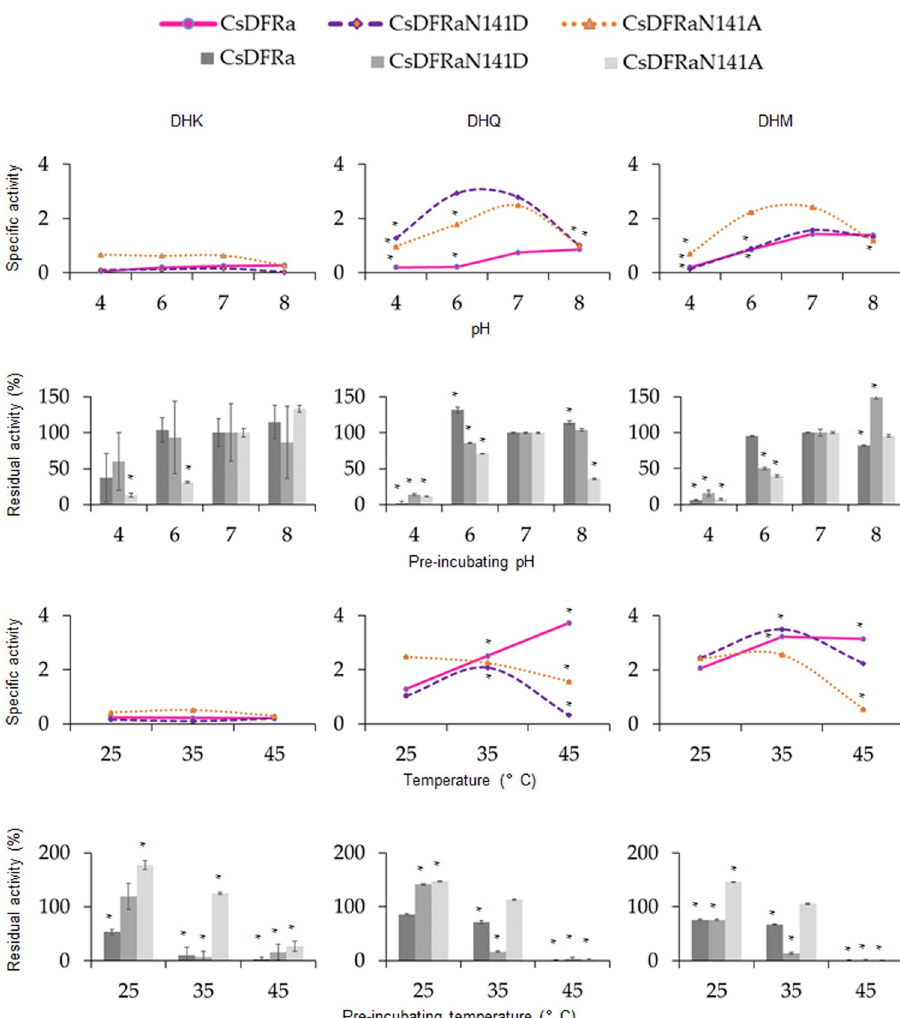
Fig 5. Optimal temperatures and pHs (line charts) and thermal and pH stability (bar charts) of CsDFRa and its two mutants. � The value is significantly different ( p < 0.05) compared to the corresponding control (pH 7 and 25˚C were the control for pH and temperature, respectively, and their results, which were not pre-incubated, were deemed as 100% activity in the enzyme stability assay).